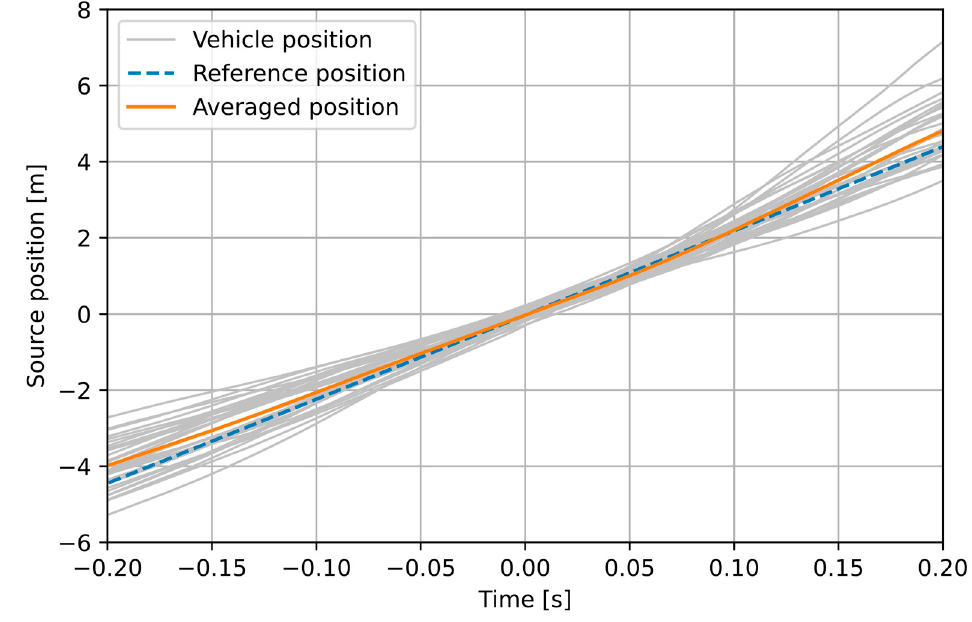
Figure 12. Position signals calculated in the experiment M.